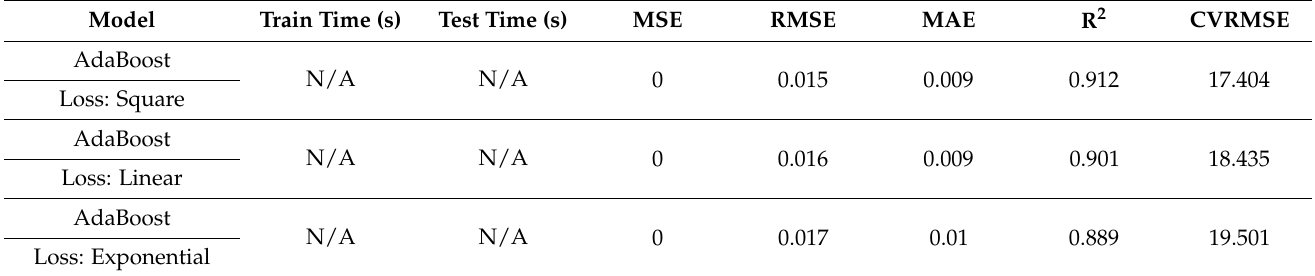
Figure 8. Train output line plot.